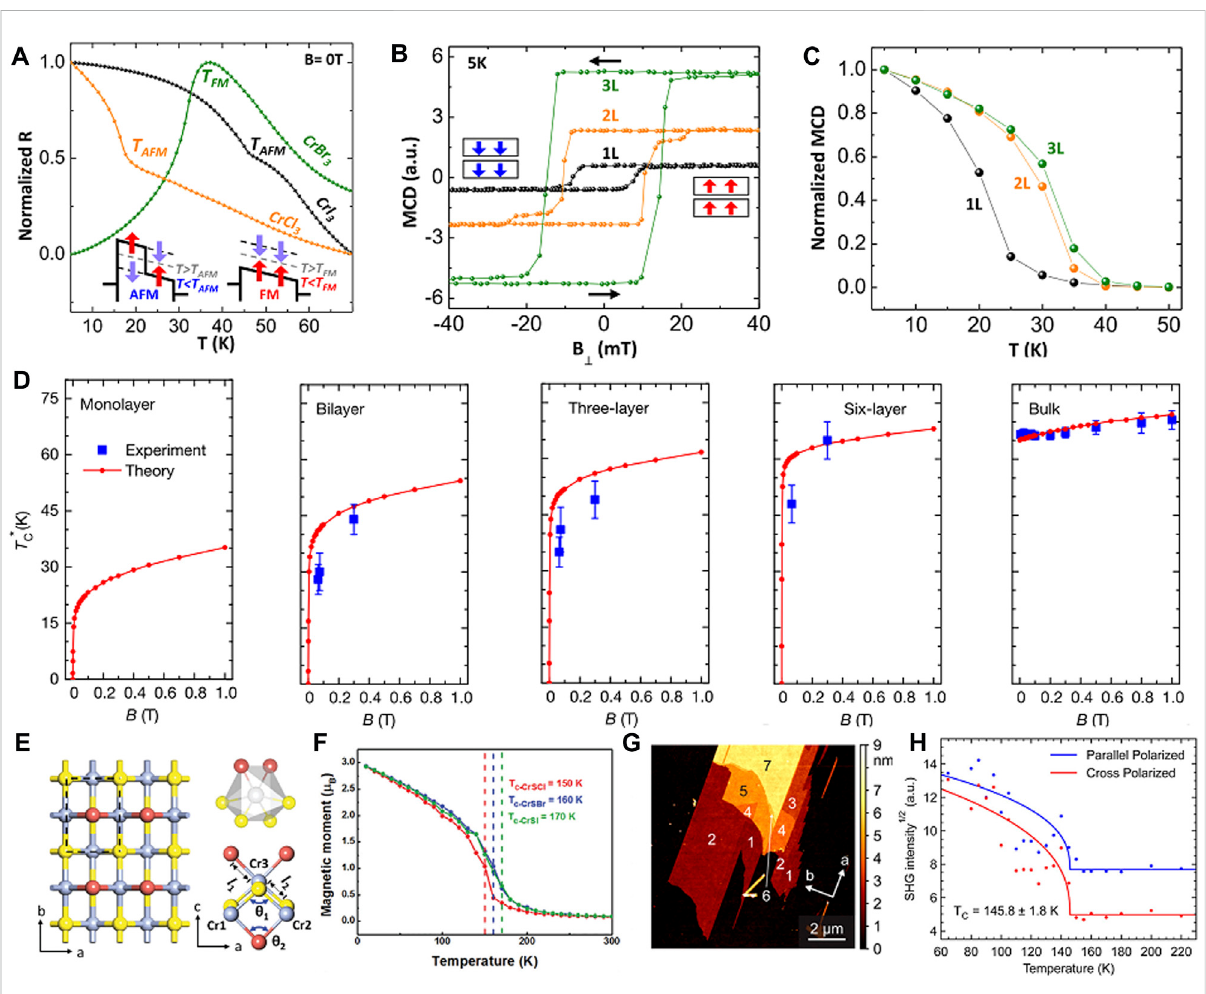
FIGURE 2 (A) Normalized temperature-dependent dc resistance of CrX 3 (X = I, Br, and Cl) at constant current of 0.1 nA. Insets show schematics of the spin-dependent tunnel barrier for AFM and FM interlayer coupling. MCD measurements on CrBr 3 . (B) Low-temperature MCD vs B ⊥ and (C) temperature-dependent normalized MCD at zero fi eld (MCD ↑ ( ↓ ) ( T) = MCD ↑ ( ↓ ),5K )for 1L, 2L, and 3L CrBr 3 . Reproduced with permission [41]. Copyright © 2018 National Academy of Sciences. (D) Experimental (blue squares) and theoretical (red circles) fi eld dependence of T C in samples ofvariousthickness.Reproducedwithpermission[2].Copyright © 2017SpringerNature. (E) ThestructureofCrSBrmonolayerand (F) evolutionofspin magnetic moment with respect to temperature of CrSX (X = Cr, S, and Br) monolayers. Reproduced with permission [25], Copyright © 2018 Royal Society of Chemistry. (G) Atomic force microscopy image of an exfoliated fl ake of varying thicknesses from one to seven layers for CrSBr and (H) square roots of the average SHG intensities of monolayer CrSBr as a function of temperature. Reproduced with permission [11]. Copyright © 2018 American Chemical